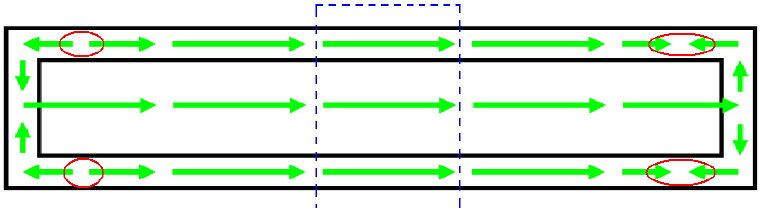
Figure 11. Magnetic field distribution of the whole sensor while h